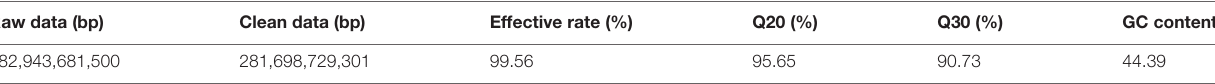
TABLE 1 | Statistics of genome sequencing data in this study. Raw data